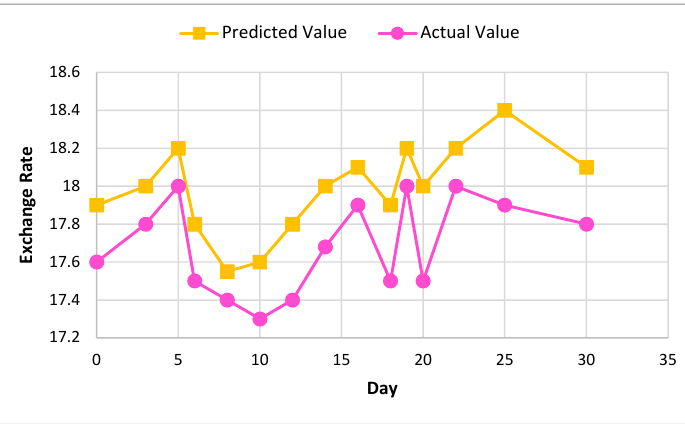
Figure 8. Actual and predicted value of Litecoin using XGBoost for 30